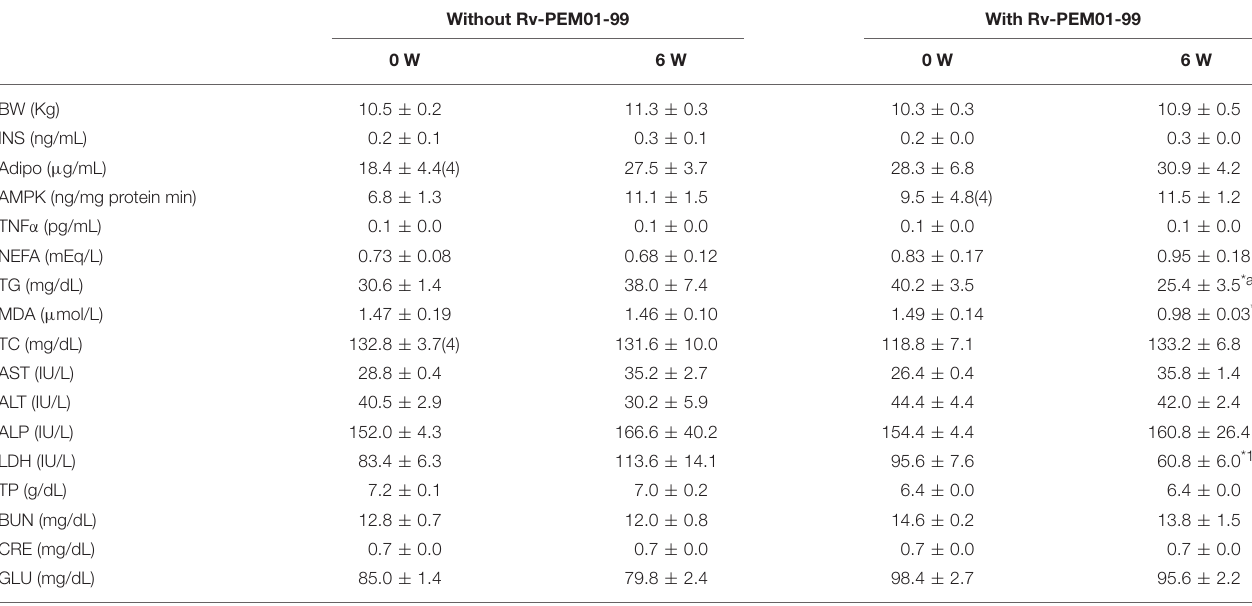
TABLE 3 | Changes in biomarker levels in control dogs fed with control